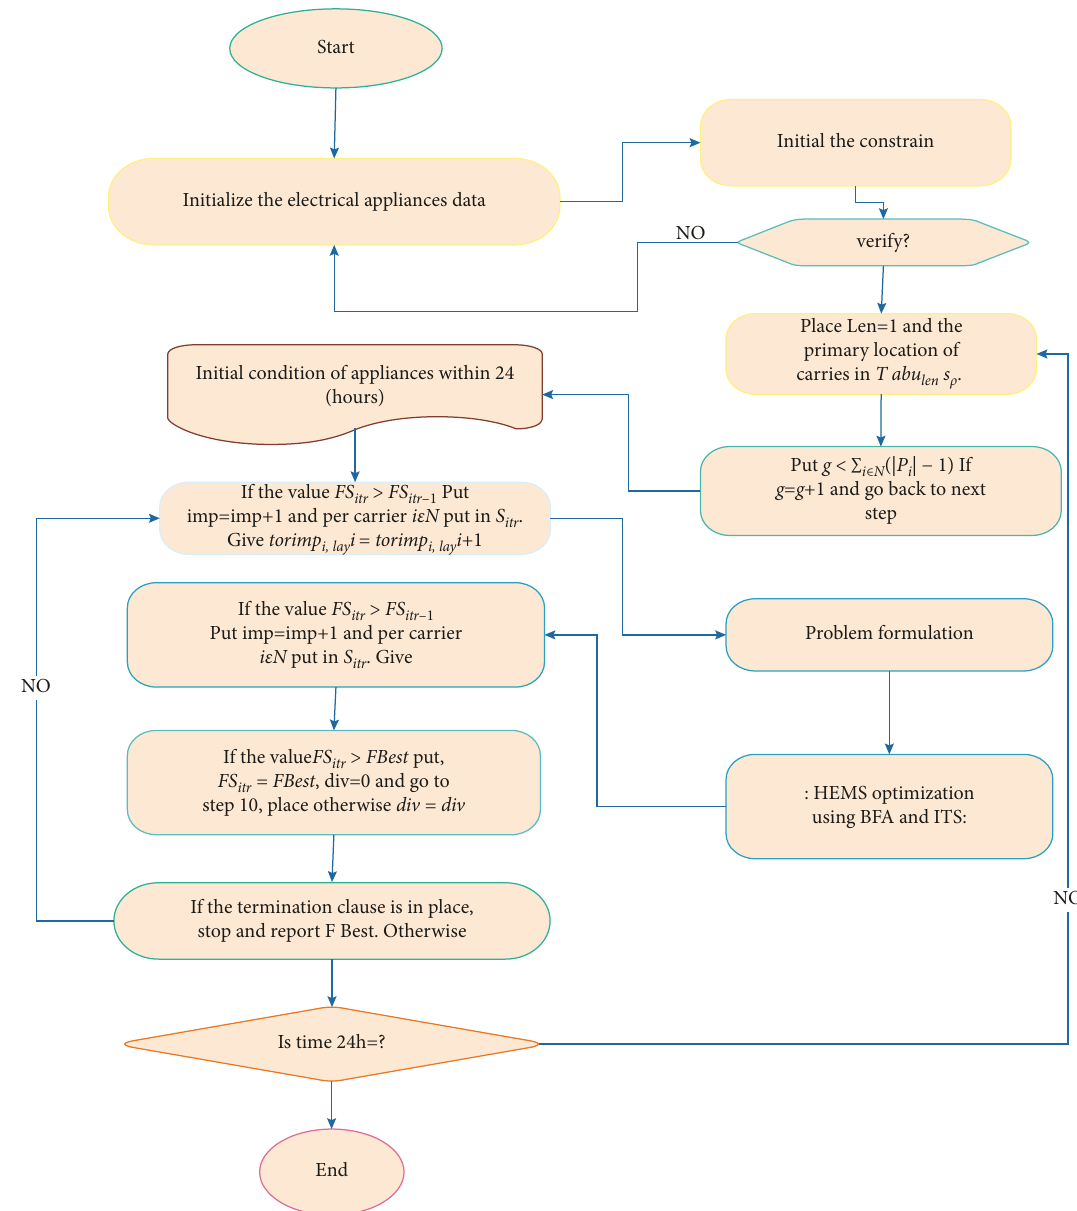
Figure 2: The Proposed protocol flowchart based on BFA and